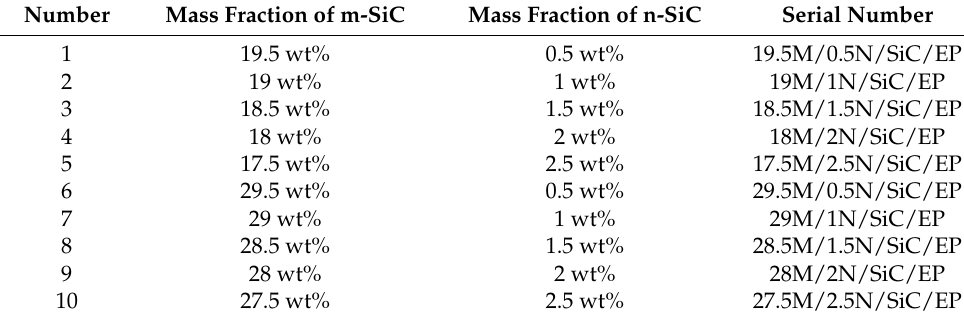
Table 3. SiC/EP composites filled with micro-nano